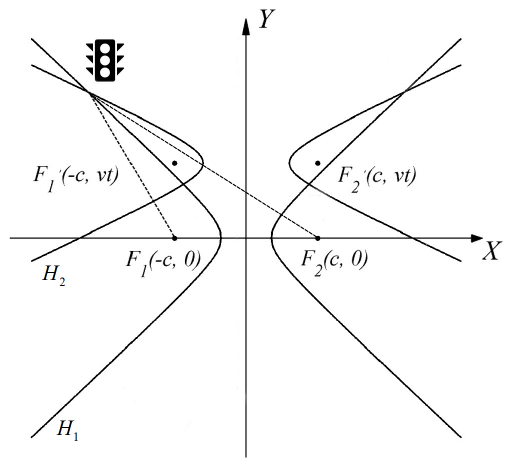
Figure 7. TDOA with one traffic light and two